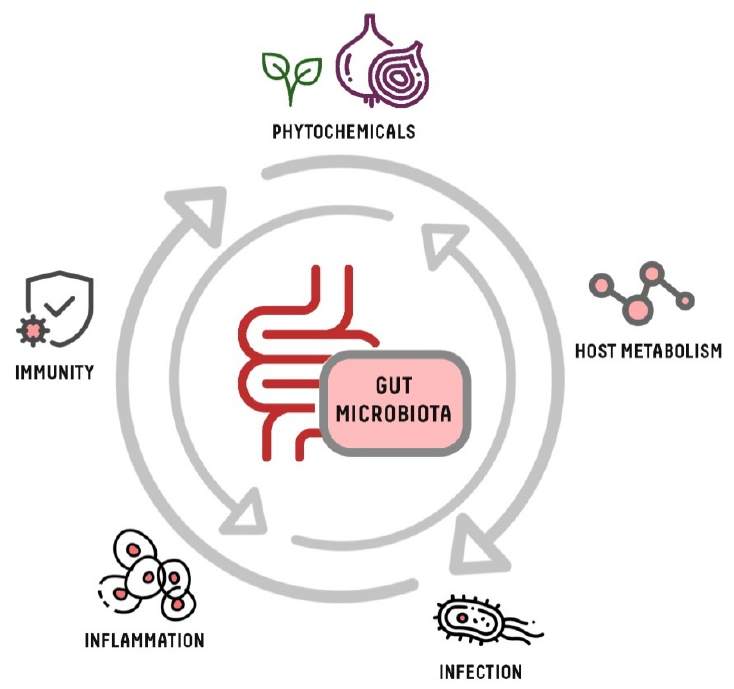
Figure 1. Interactions between host and gut microbiota. Phytochemicals influence the intestinal microbiota, which establishes mutual interactions and interdependencies with the host.